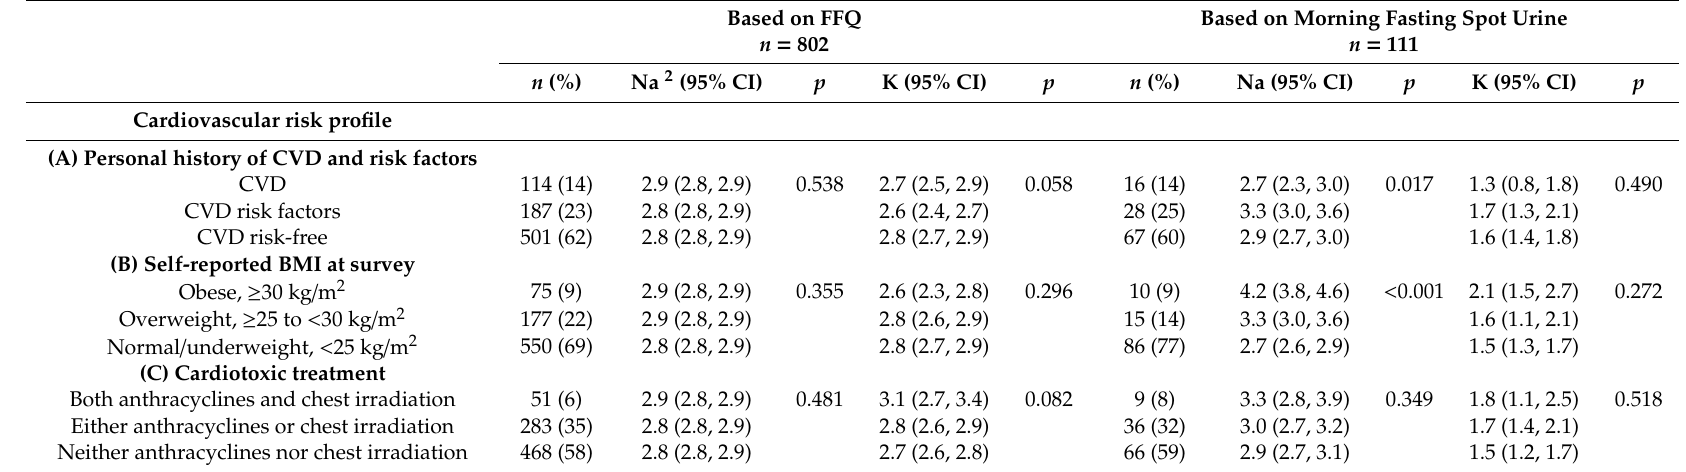
Table 4. Mean sodium (Na) and potassium (K) intake (g / day) in childhood cancer survivors by cardiovascular risk profiles (A–C), retrieved from ANCOVA 1.